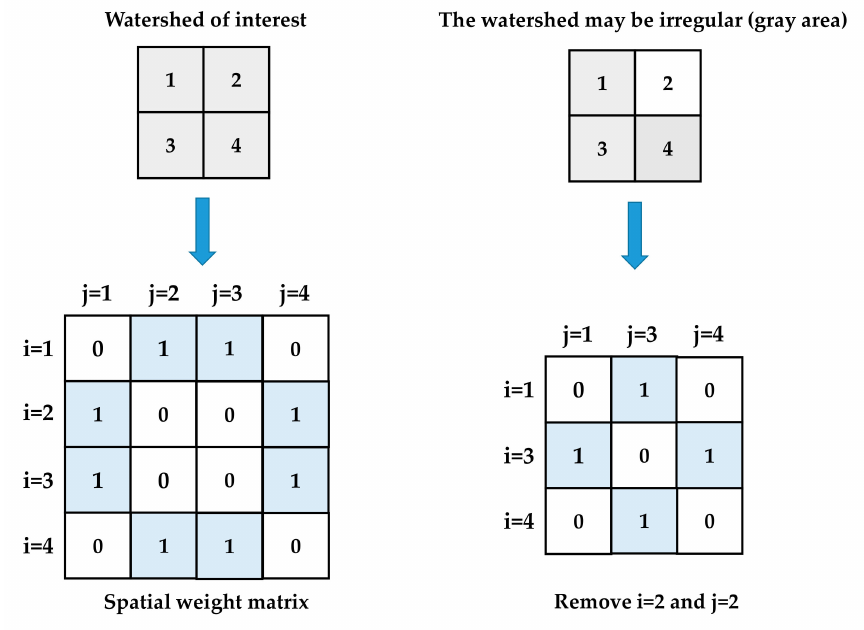
Figure 2. The calculation process of the spatial weight